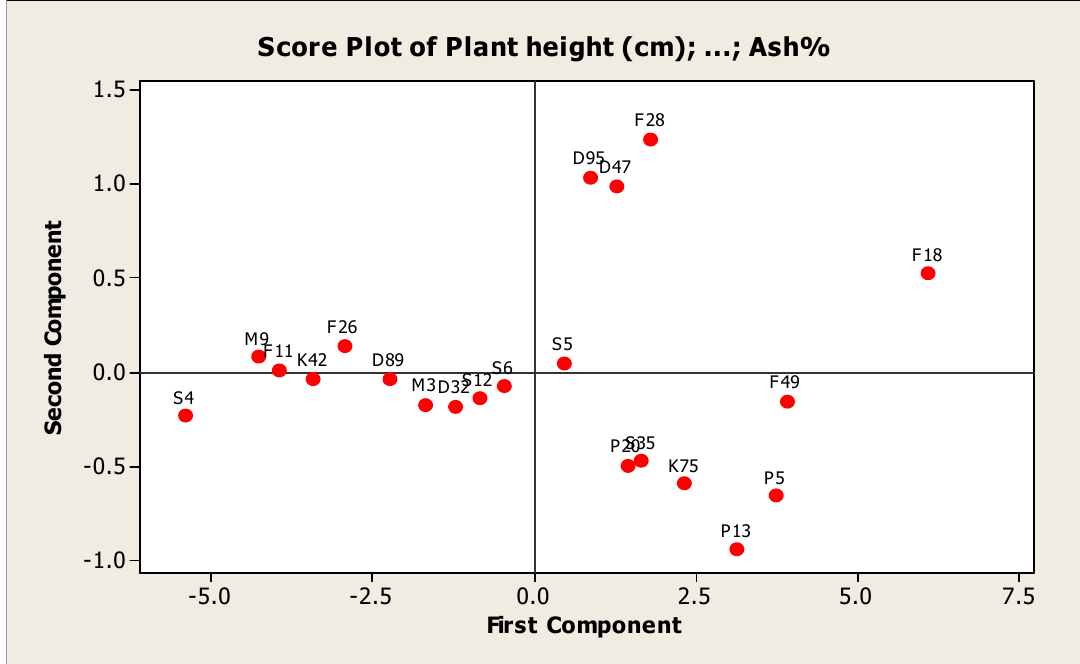
Figure 10. Principal component analysis of measured traits in twenty one genotypes of alfalfa.